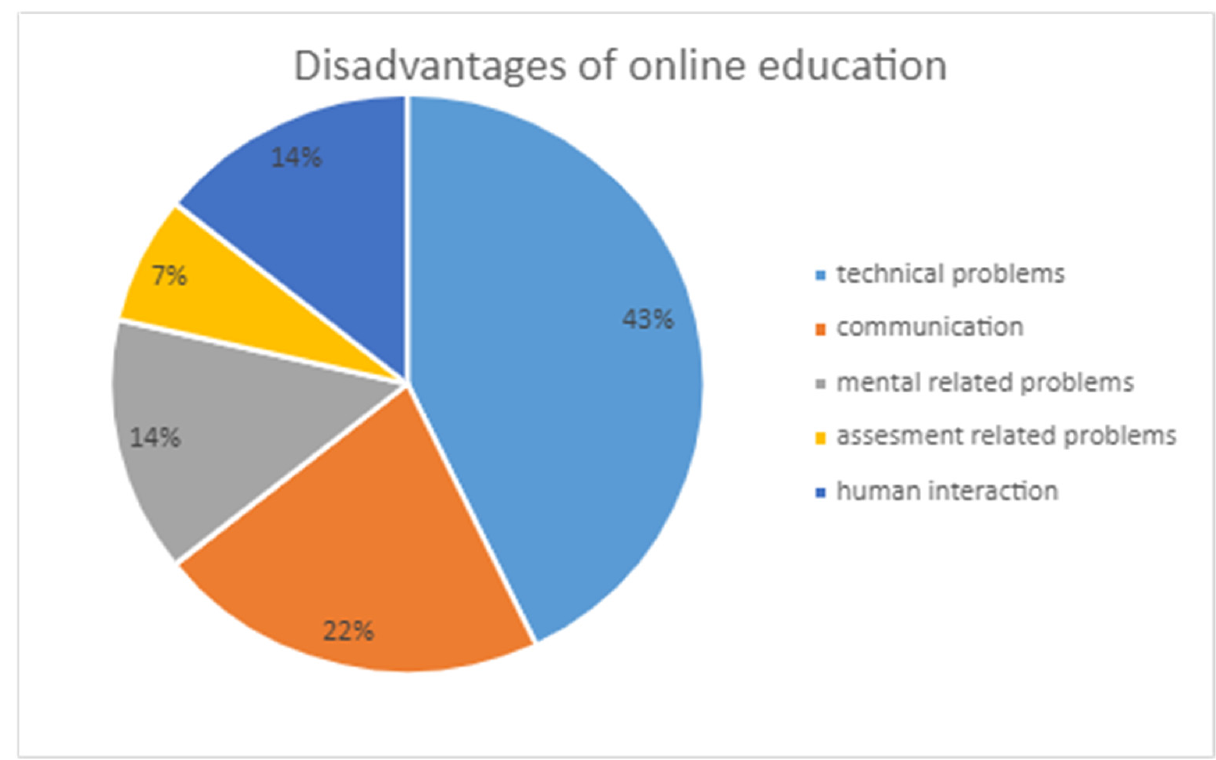
Figure 7. Disadvantages of online education. Source: authors’ own analysis/compilation.